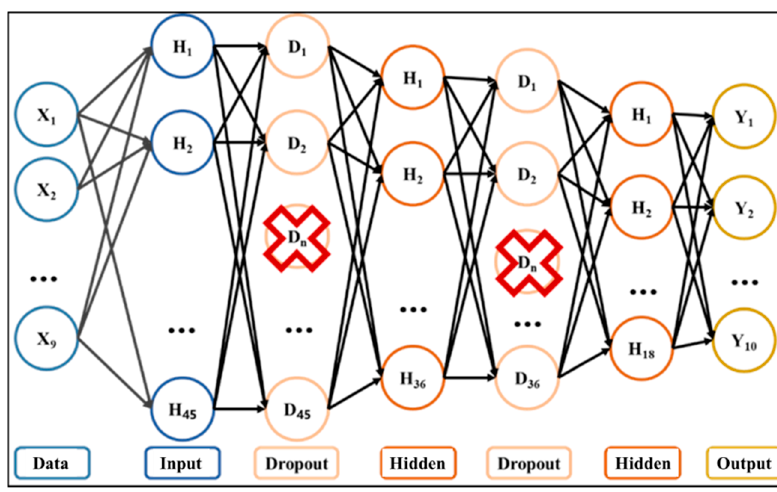
Figure 4. The deep learning flow chart.